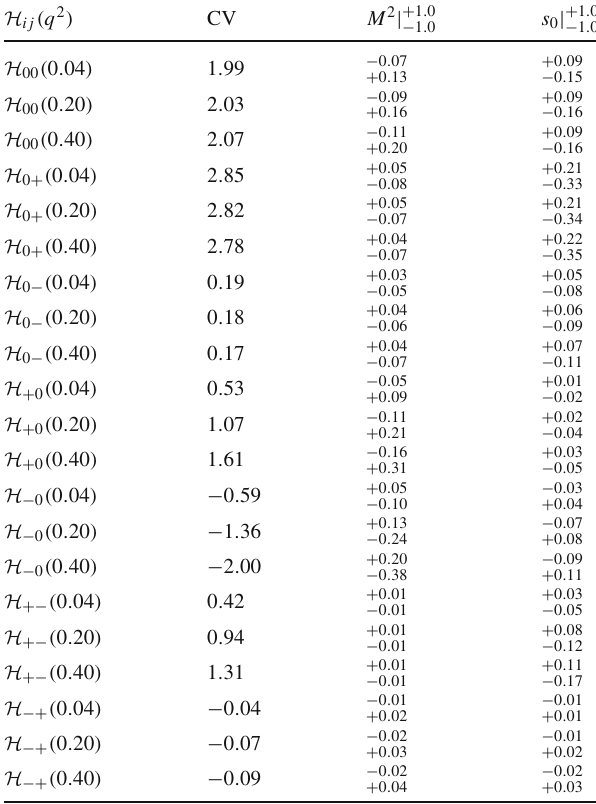
Fig. 2. The anatomy of the LCSRs uncertainty are presented in Table 1 by taking the result at three momentum transfer points, saying q 2 = 0 . 04 , 0 . 20 and 0 . 40 GeV 2 . It shows that